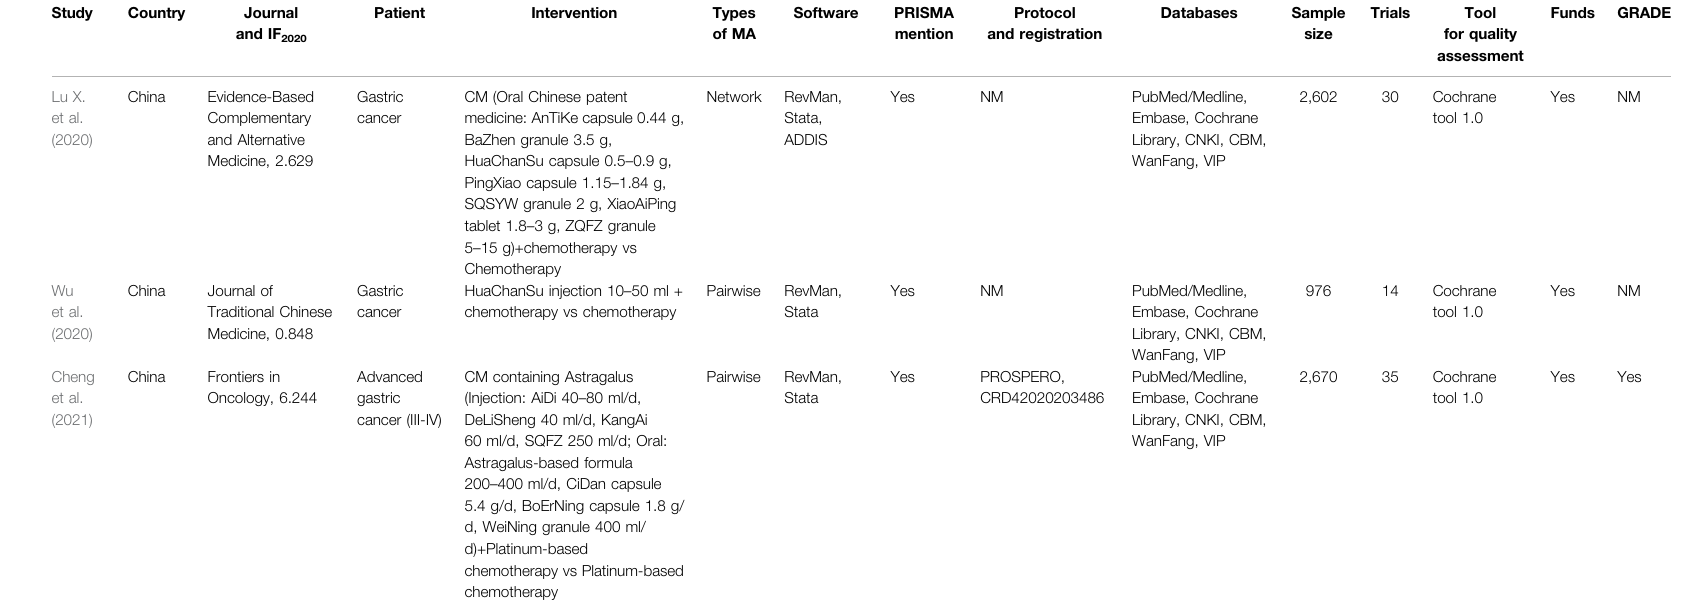
TABLE 1 | ( Continued ) Basic characteristics of the included